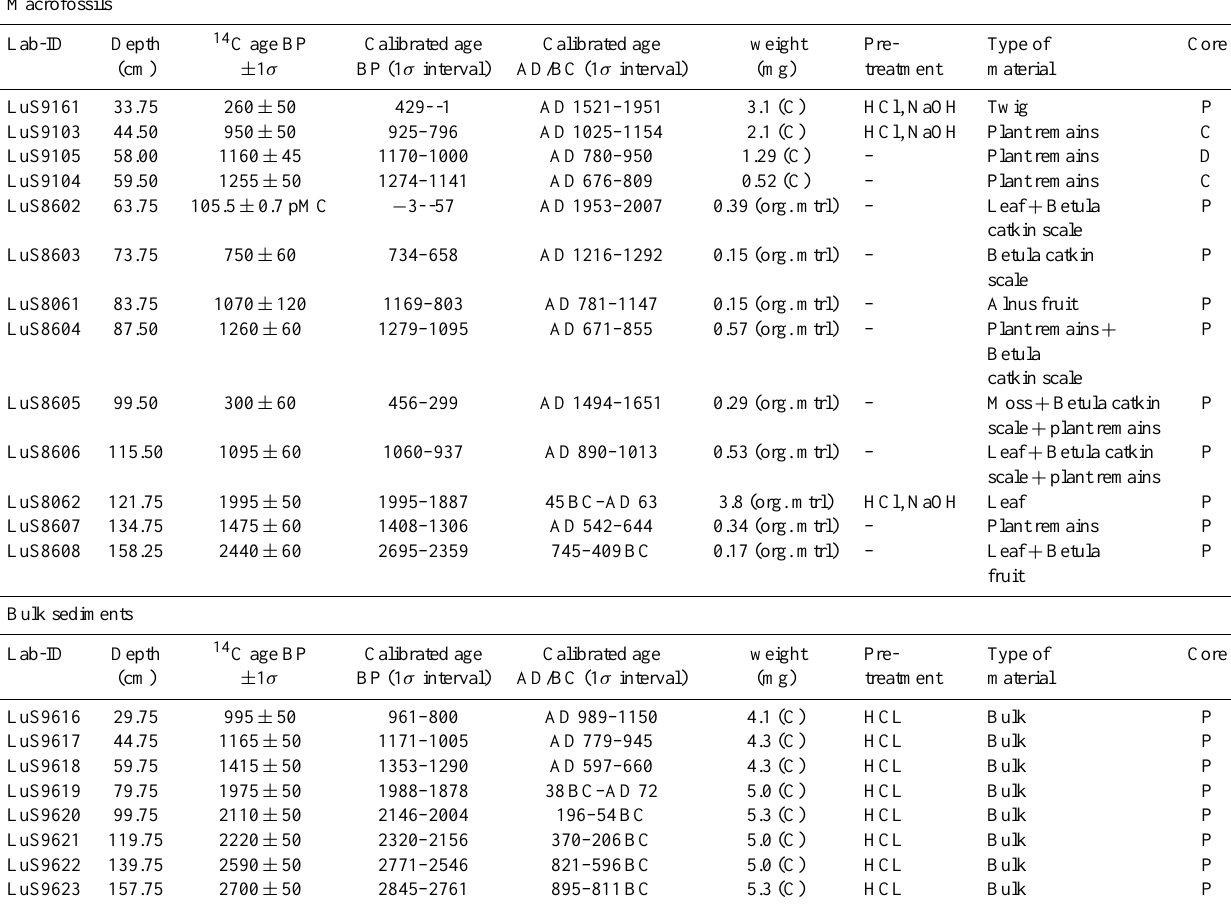
Table 1. Radiocarbon dates on macrofossils and bulk sediment samples. Calibrated age intervals are those provided by the OxCal program when calculated for each sample individually (not in a sequence). The 14 C age for sample LuS8602 is younger than AD1950 and therefore expressed as percent modern carbon (pMC). Sample weights are those reported by the laboratory for material used for graphitization (after any pre-treatment). Weights for the first dated sample batches (LuS8XXX) were reported as mg organic material, while weights for samples dated later were reported as